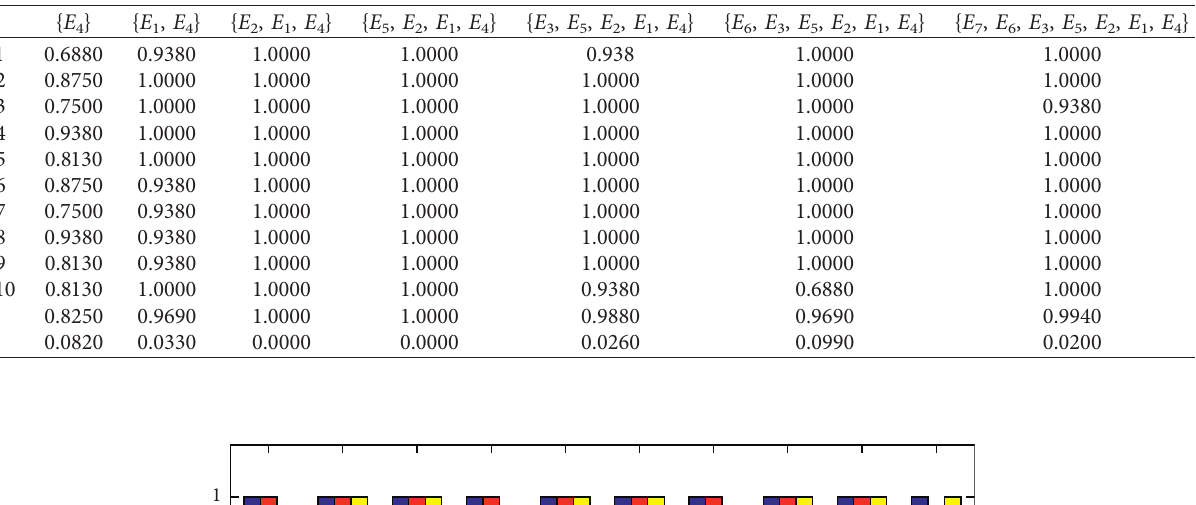
Table 7: Feature selection based on the random forest via the 10-fold CV procedure.